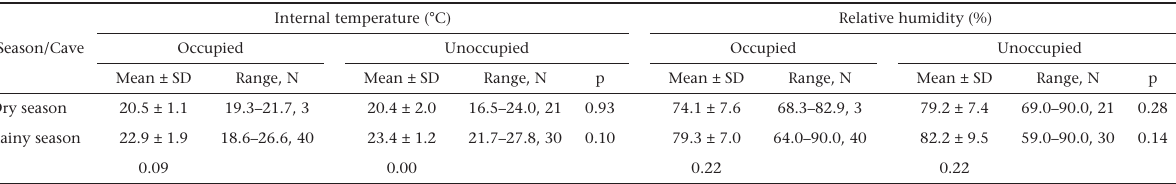
Table 3. Comparisons of means (Student t-test, p < 0.05) of microclimatic characteristics among 32 caves occupied by bats and 34 un- occupied caves at the APA karst area of Lagoa Santa, Minas Gerais, Brazil. The sample size (N) represents the number of times that the measure was taken during the monthly inspections.